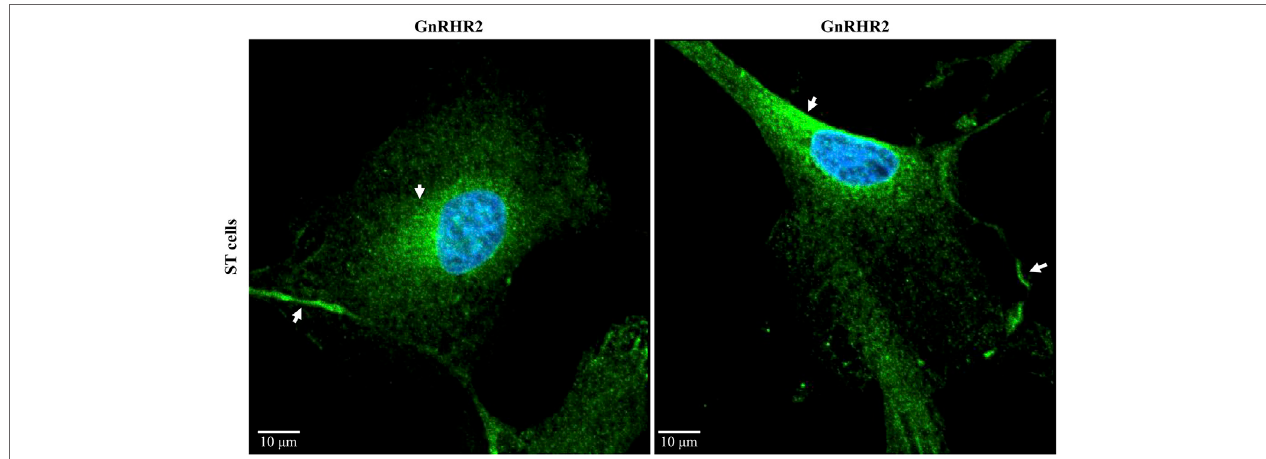
FiGURe 6 | Subcellular localization of the GnRHR2 in a swine testis (ST)-derived cell line. Immunocytochemistry was performed on ST cells (CRL-1746; American Type Culture Collection, Rockville, MD, USA) with an antibody directed against GnRHR2 (1:100–1:200; sc-162889; Santa Cruz Biotechnology, Santa Cruz, CA, USA) and labeled with an Alexa Fluor 488 secondary antibody (green); nuclei were stained with DAPI (blue). The experiment was replicated three times. Two representative confocal microscopy images are shown. Note the plasma membrane and perinuclear staining (arrows). The scale bar represents 10 µm. Adapted from Cederberg et al.